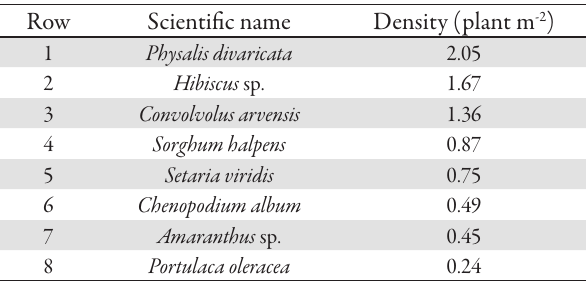
Tab. 1. Density of different weeds (plant m -2 ) in sugar beet crops in the west of Iran